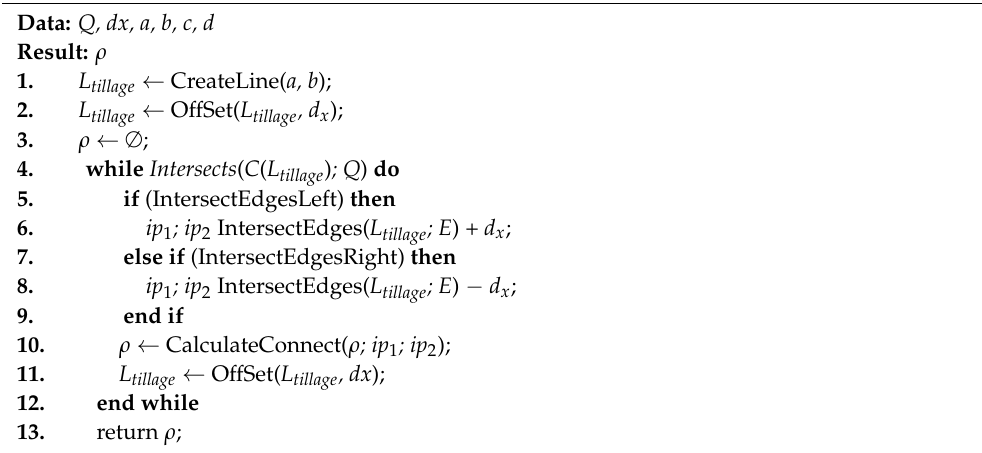
Algorithm 1: Polygon ROI edge-vertex identification (GetPath( a, b, c, d )). Calculating the BFP